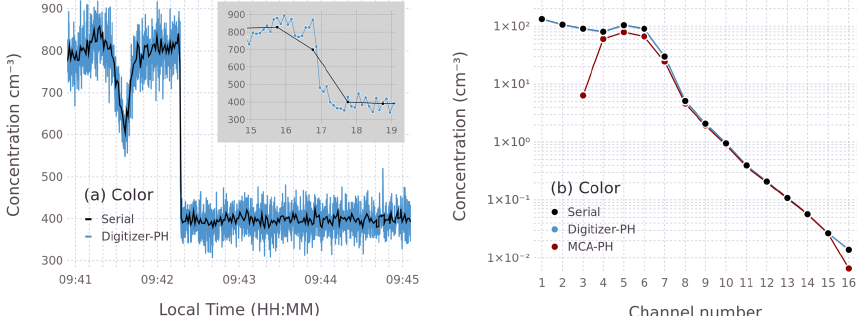
Figure 8. (a) Comparison of 1Hz serial concentration and 10 Hz digitizer concentration. The inset is a magnified view corresponding to the transition between 9:42:15 and 9:42:19. (b) Comparison of the serial distribution, digitizer-PH distribution, and MCA-PH distributions. Serial and digitizer-PH distributions are